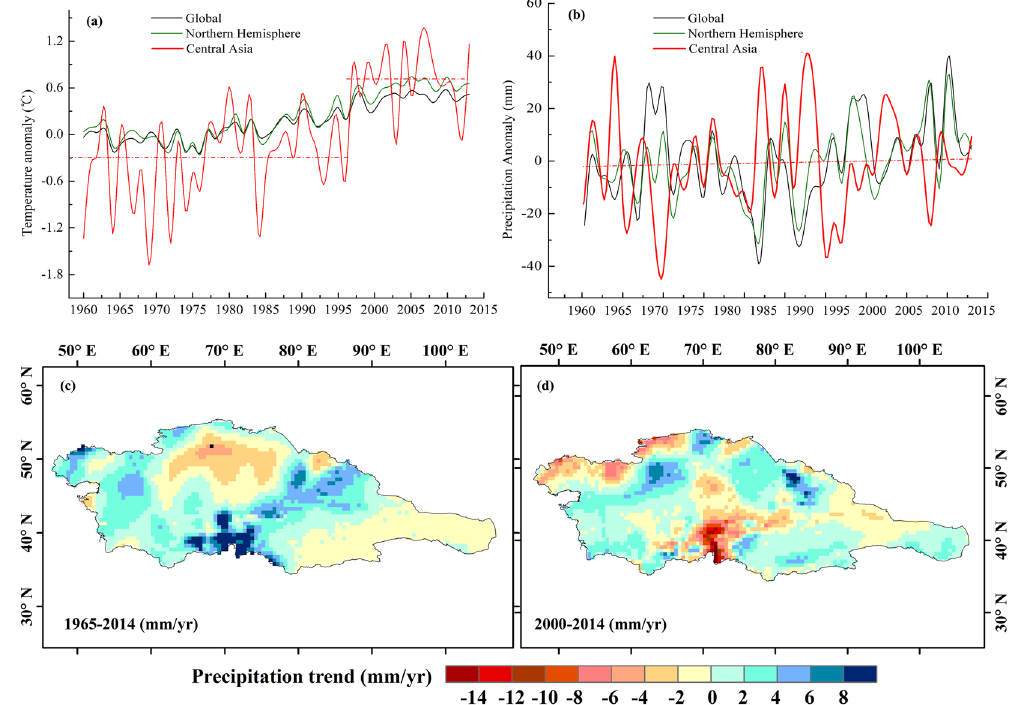
Figure 3. Spatio-temporal changes of temperature and precipitation during 1965–2014. ( a ) Annual temperature of Global, Northern Hemisphere and Central Asia; ( b ) annual precipitation of Global, Northern Hemisphere and Central Asia; ( c ) spatial trend of precipitation in Central Asia during 1965–2014; ( d ) spatial trend of precipitation in Central Asia during 2000–2014. (Generated by ArcGIS 10.2, URL: